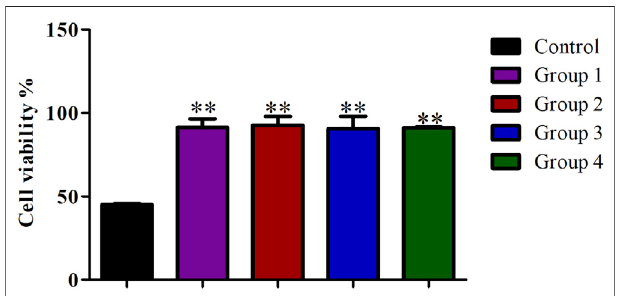
FIGURE 6 | The effect of different cell puri fi cation methods on single cell viability. Data are presented as means ± SD; ** p value < 0.05.